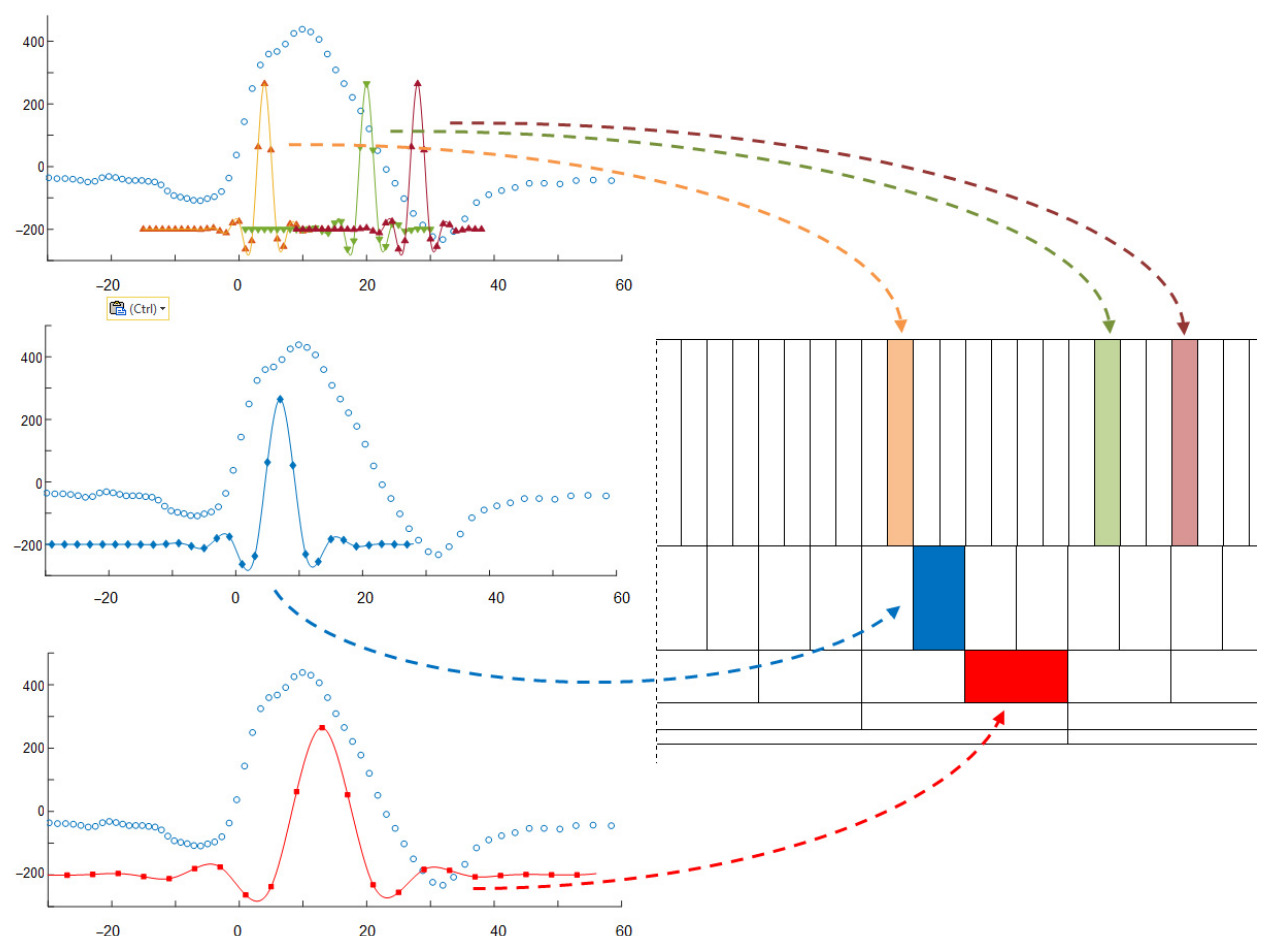
Figure 5. Principle of direct transform of non-uniform signal to uniform time-scale representation.